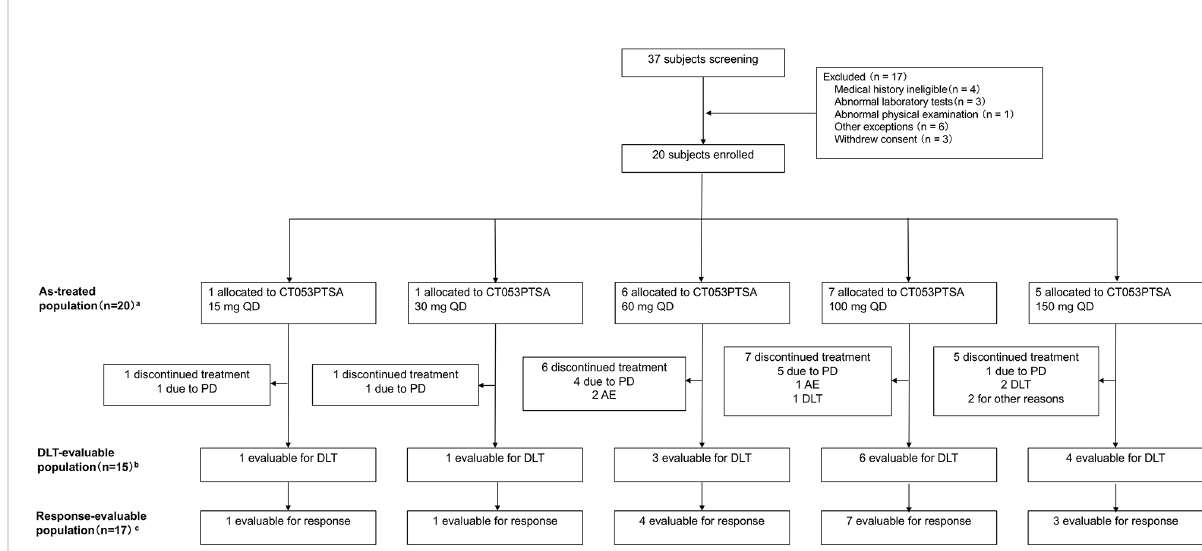
FIGURE 3 Flow chart of patients enrolled in the study. A total of 20 patients received at least one dose of CT053PTSA. a The as-treated population included patients who received any dose of CT053PTSA, grouped according to actual dose received; b The population that was eligible to for DLT assessment included all the patients enrolled in the dose-escalation phase who received one full dose of CT053PTSA and completed the safety follow-up through the DLT evaluation period, de fi ned as the time during cycle 0 (7 days after a single dose) and cycle 1 (multiple doses, including a 7-day observation period after 28 days of administration), or who experienced any DLT during this period; c The population that was eligible for response assessment included all patients in the as-treated population who had ≥ 1 postbaseline tumor assessment or alternatively who died from any cause or who discontinued treatment due to clinical PD prior to any postbaseline tumor assessment. AE, adverse event; PD, progressive disease; DLT, dose-limiting